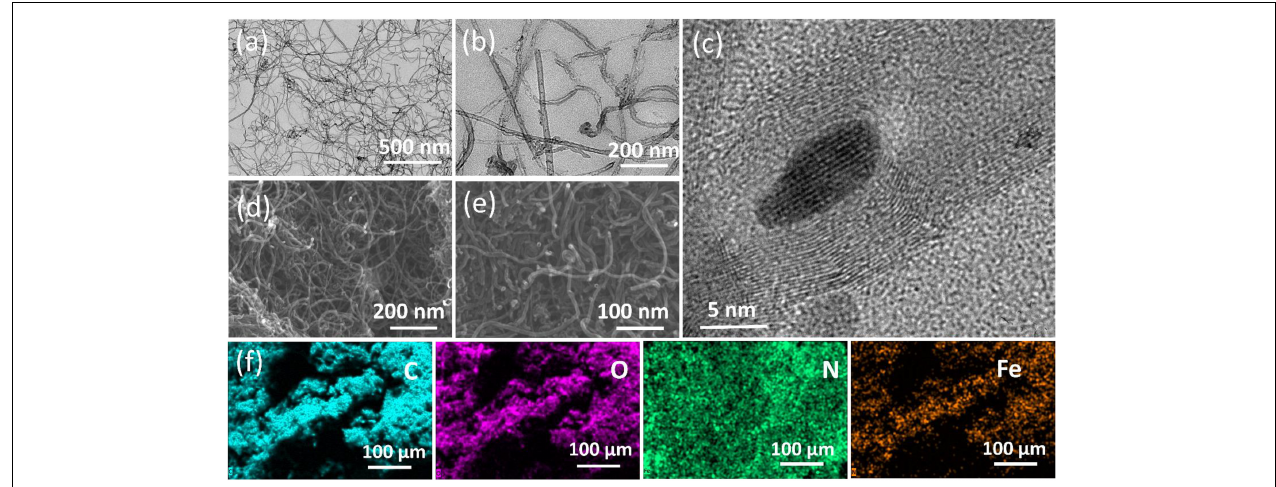
FIGURE 2 | TEM images of the pristine MWCNTs (a) and Fe 2 O 3 @MWCNTs (b,c) . SEM images of the pristine MWCNTs (d) and Fe 2 O 3 @MWCNTs (e) . SEM-EDX elemental mapping (f) for carbon, oxygen, nitrogen, and iron of the Fe 2 O 3 @MWCNT nanocomposite particles.